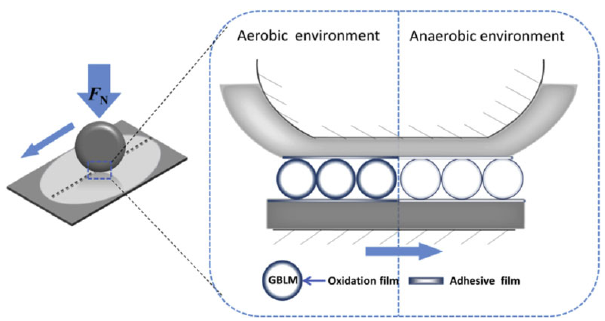
Fig. 14 Schematic of the proposed lubrication model of steel with GBLM lubrication in aerobic and anaerobic environments [205]. Reproduced with permission from Ref. [205], ©